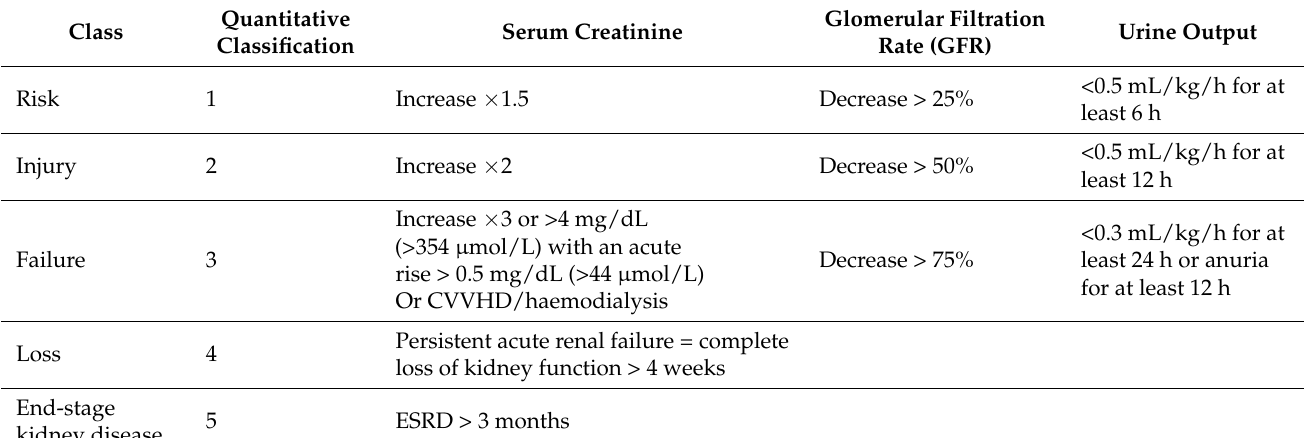
Table 1. The RIFLE diagnosis and classification of AKI.